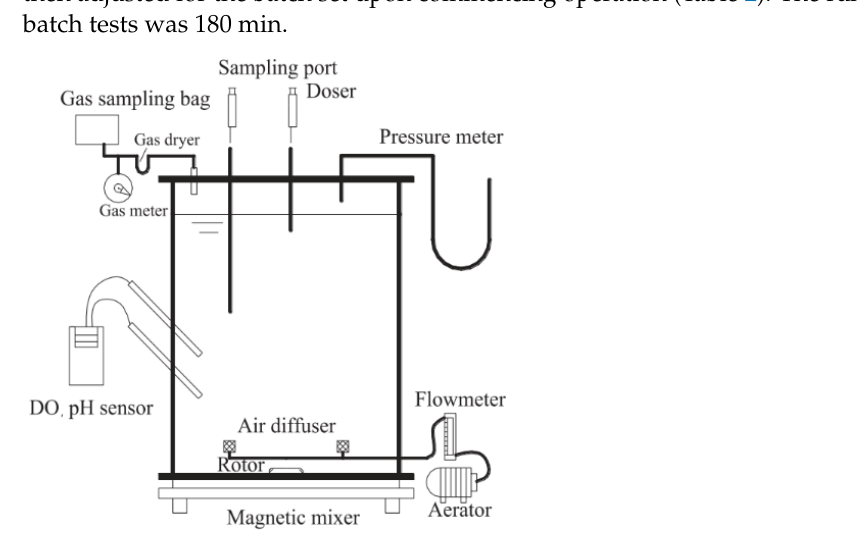
Figure 1. N 2 O emission during partial nitrification (partial nitrification effluent +NH 4 Cl-N/NaNO 2 - N, DO = 0.5 mg/L).